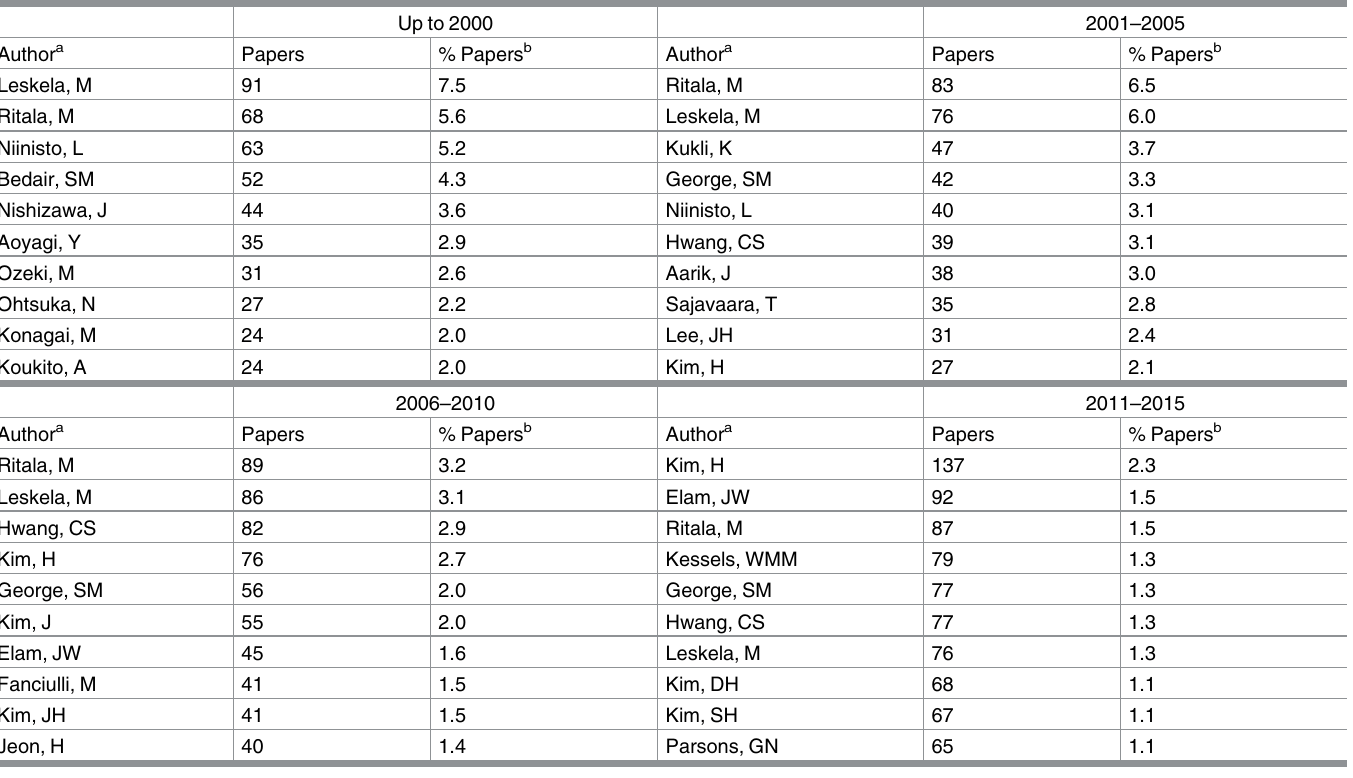
Table 5. Top 10 most productive authors in different periods of